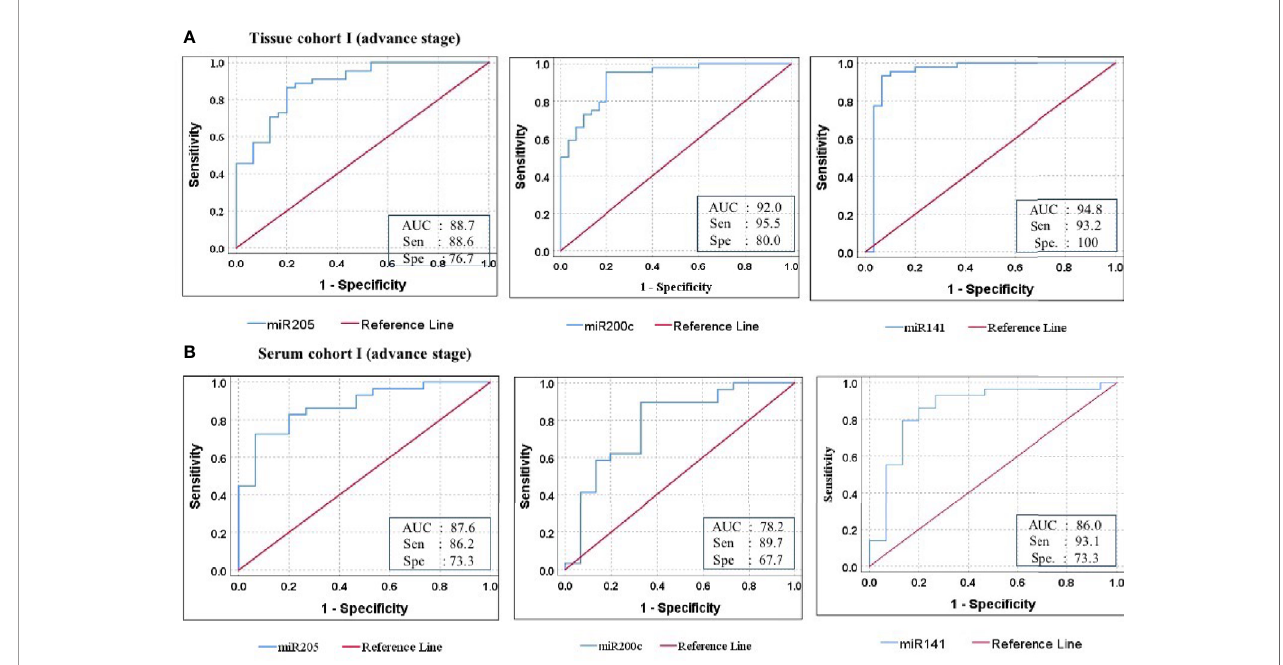
FIGURE 5 | ROC curve analysis in cohort-I of tissue and serum to access the ability of each miRNA signature to diagnose ovarian cancer. (A) In tissue cohort-I ( n = 74), the combined measure of sensitivity and speci fi city of miR-205, miR-200c, and miR-141 was represented by AUC at 95% CI, p -value = 88.7 (0.813 – 0.961, p < 0.001), 92.0 (0.860 – 0.981, p < 0.0001), and 94.8 (0.881 – 1.016, p < 0.0001), respectively. (B) In serum cohort-I ( n = 45), the AUC of miR-205, miR-200c, and miR- 141 at 95% CI, p -value = 87.6 (0.773 – 0.979, p < 0.001), 78.2 (0.627 – 0.936, p < 0.0001), and 86.0 (0.729 – 0.990, p < 0.0001) respectively. Diagonal reference line acts as a performance measure of the diagnostic test, i.e., whether test yields the negative or positive outcomes by chance or due to relation with the true disease status. AUC, area under the curve; Sen, sensitivity; Sep, speci fi